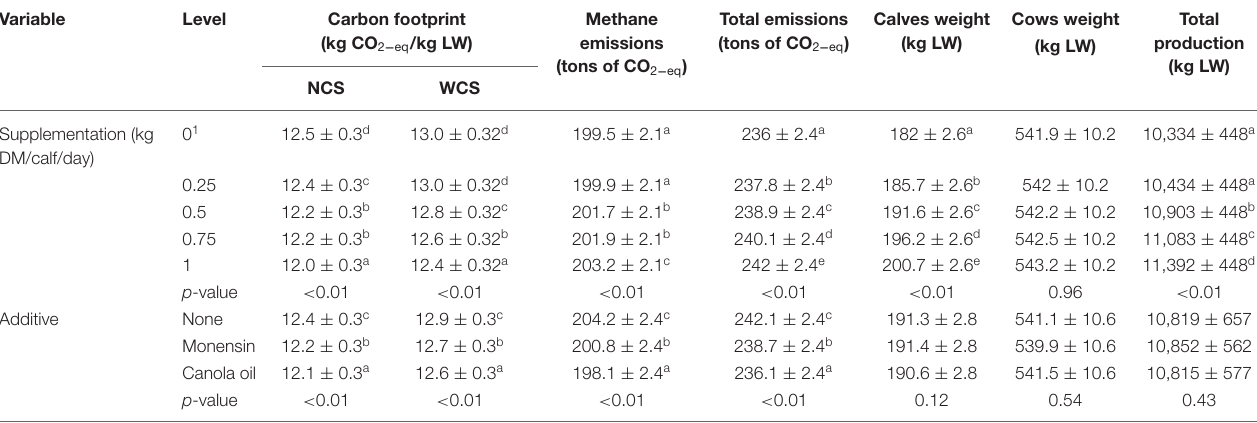
TABLE 2 | Simulated carbon footprint (CF), methane emissions, total emissions, and productive variables according to calf supplementation (creep feeding) and additives (monensin and canola oil) used in the baseline scenario (stocking rate of 0.7